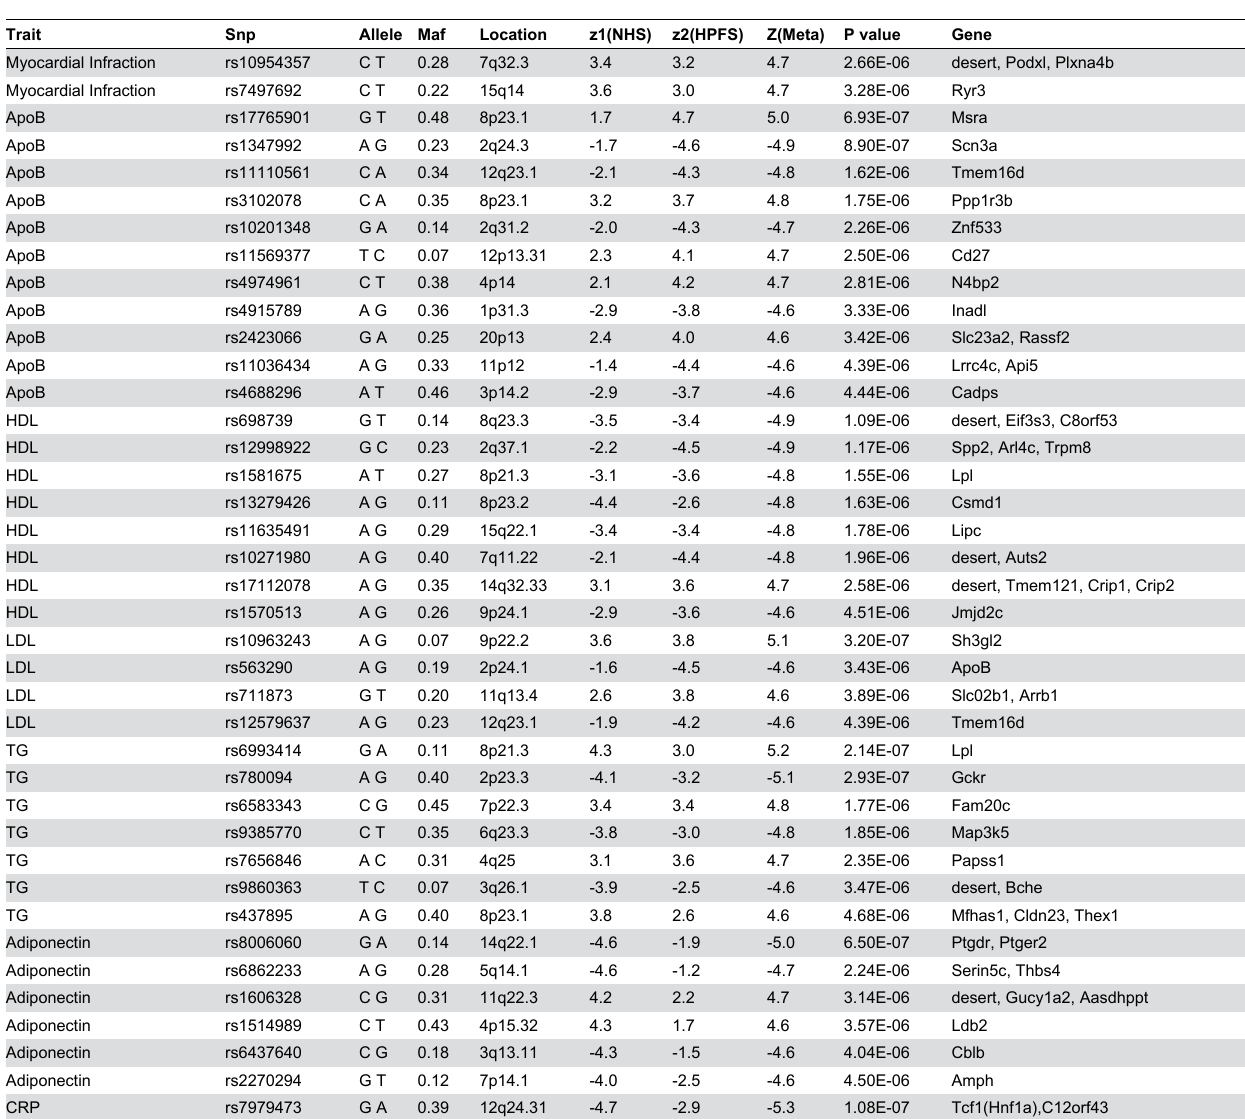
Table 3. Suggestive SNP associations for traits of